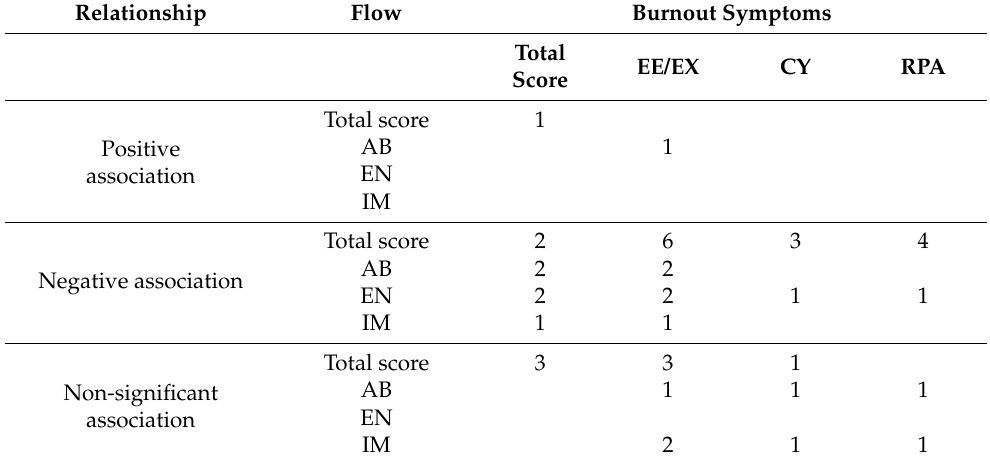
Table 2. Overview of the positive, negative, and non-significant associations found in the studies.